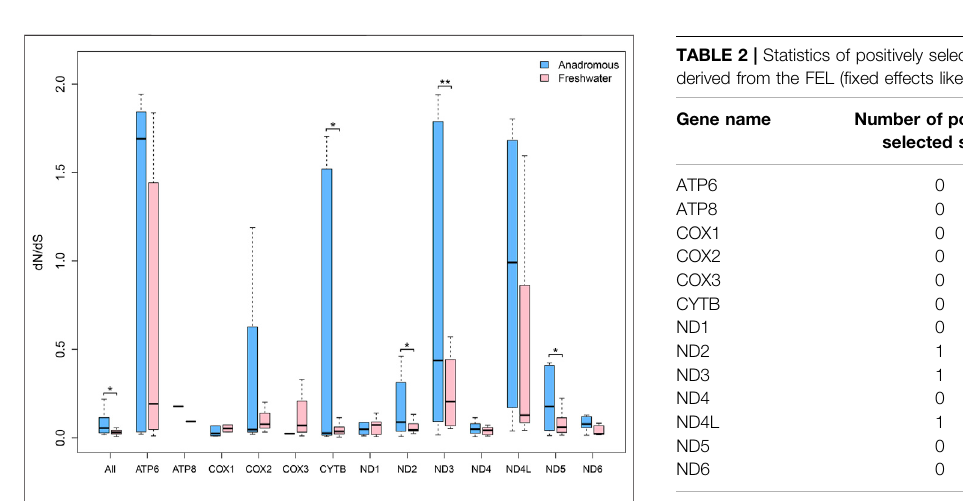
FIGURE 2 | dN/dS ratios for each of 13 mitochondrial protein-coding genes of freshwater and anadromous salmonids.